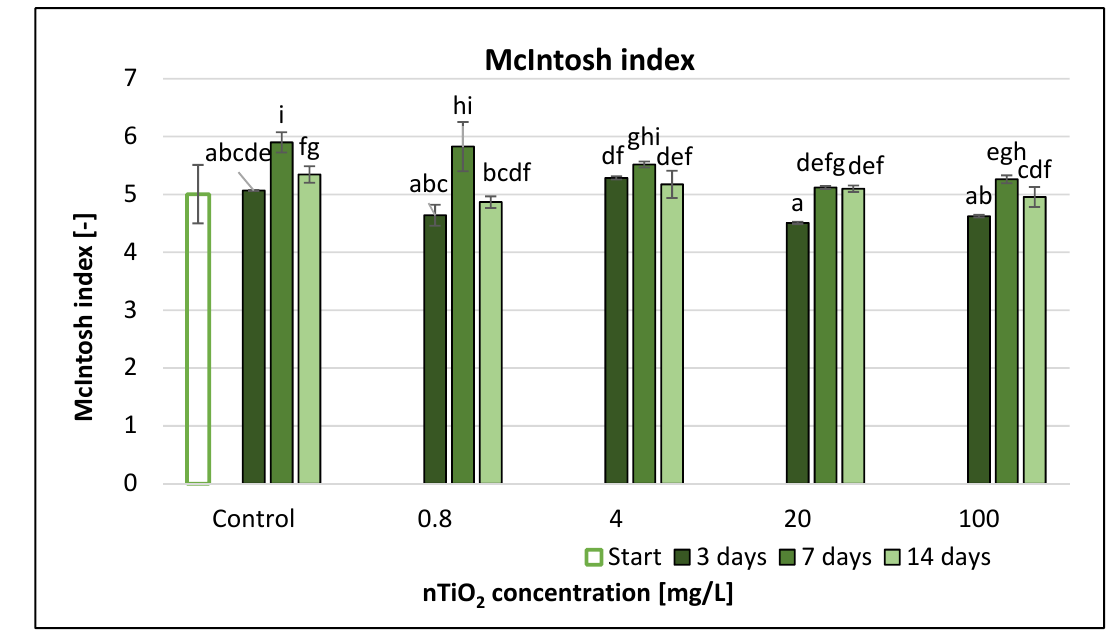
Figure 13. The effect of TiO 2 nanoparticles on freshwater McIntosh index value. Letters on the columns indicate significant differences (level of significance: p < 0.05).